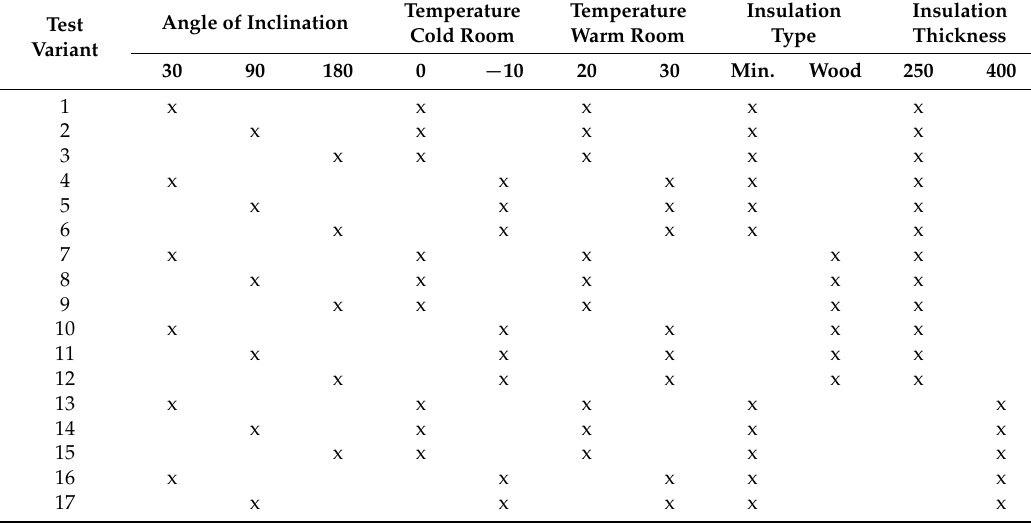
Table 2. Overview of test parameters and conditions during the different Hot-Box measurements. “x” denotes the build up of the different